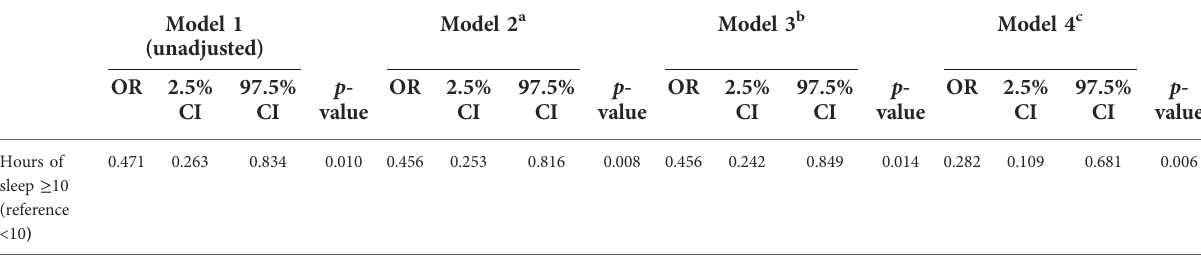
TABLE 3 Logistic multivariate models: dependent variable poor-to-moderate adherence to Mediterranean diet (KidMed score ≤ 7); independent variable (sleep ≥ 10 h/day); adjusted for different sets of covariates. Model 1